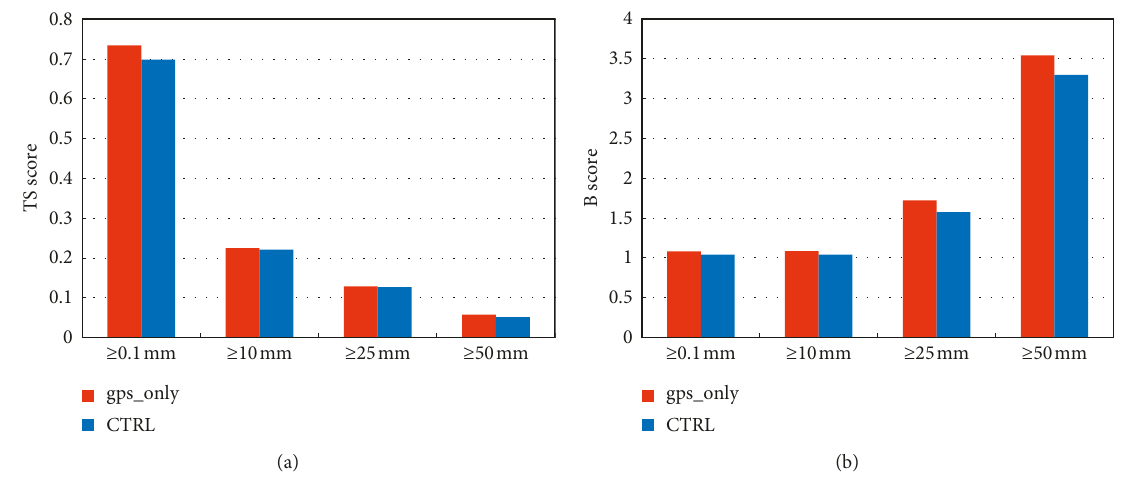
Figure 5: Comparison of the (a) TS score and (b) B score for 48-hour cumulative precipitation across several schemes from May 4, 2009, to August 30, 2009.